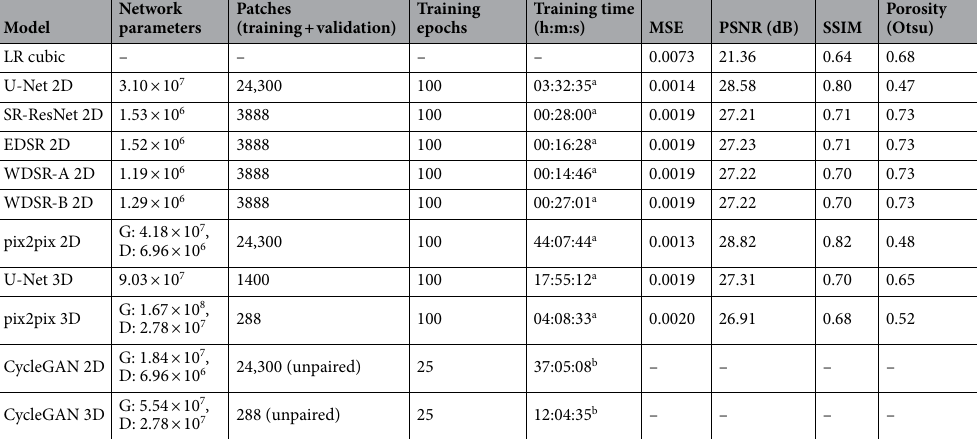
Table 1. Training details and image quality metrics for the trained 2D and 3D CNNs and GANs. Image quality metrics (respect to HR images), together with porosity values, were obtained from validations slices. Network parameters for GANs (pix2pix and CycleGAN) are reported for generators (G) discriminators (D). Training time refers to two different GPUs: NVIDIA GeForce RTX 3070 (a) and NVIDIA GeForce RTX 3090 Ti (b). CycleGAN was trained on unpaired images, which do not allow to estimate image quality metrics; validation data looks promising from a visual inspection, but still not recommendable for estimating transport properties (see text for